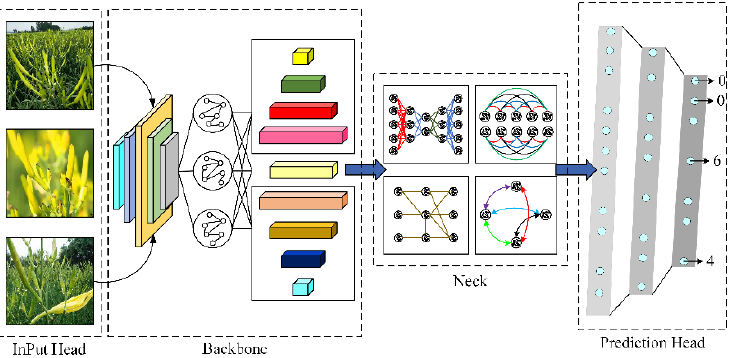
Figure 1. YOLOv5 algorithm process.